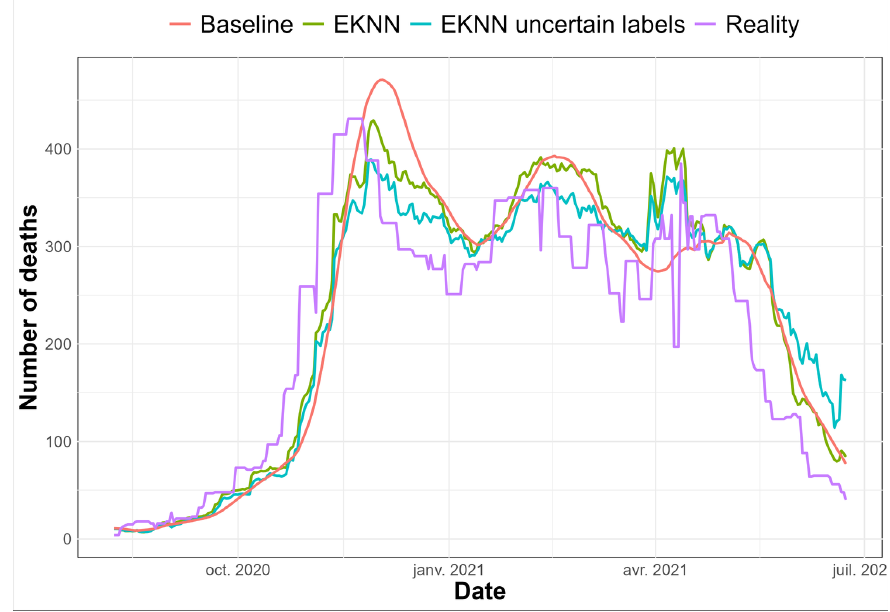
Fig 3. Predictive results on data imputed with time-E K NN imputation method, comparison with true labels: K = 1: q = 3— v = 0.3.